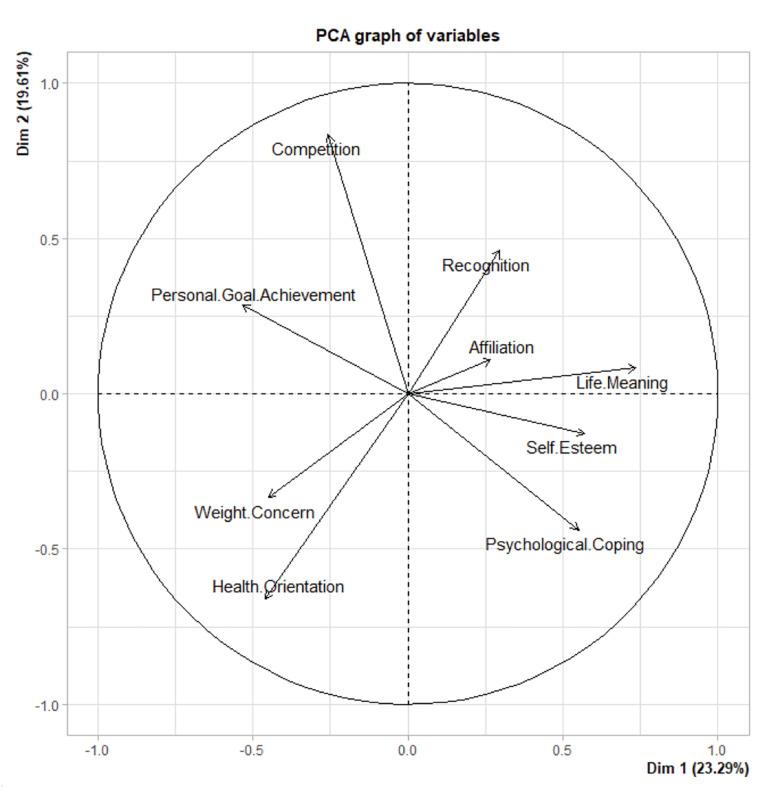
Principal Component Analysis (PCA) graph of variables, showing data for the nine Motivations of Marathoners Scale (MOMS) dimensions.